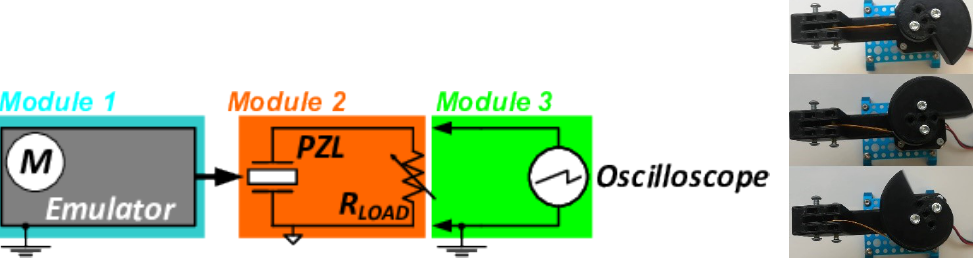
Figure 7. Electrical diagram of the test bench utilized for the evaluation of the piezoelectric response of ZnO samples under repeated mechanical deformation ( left ) and snapshots showing the action performed by the spiral actuator ( right